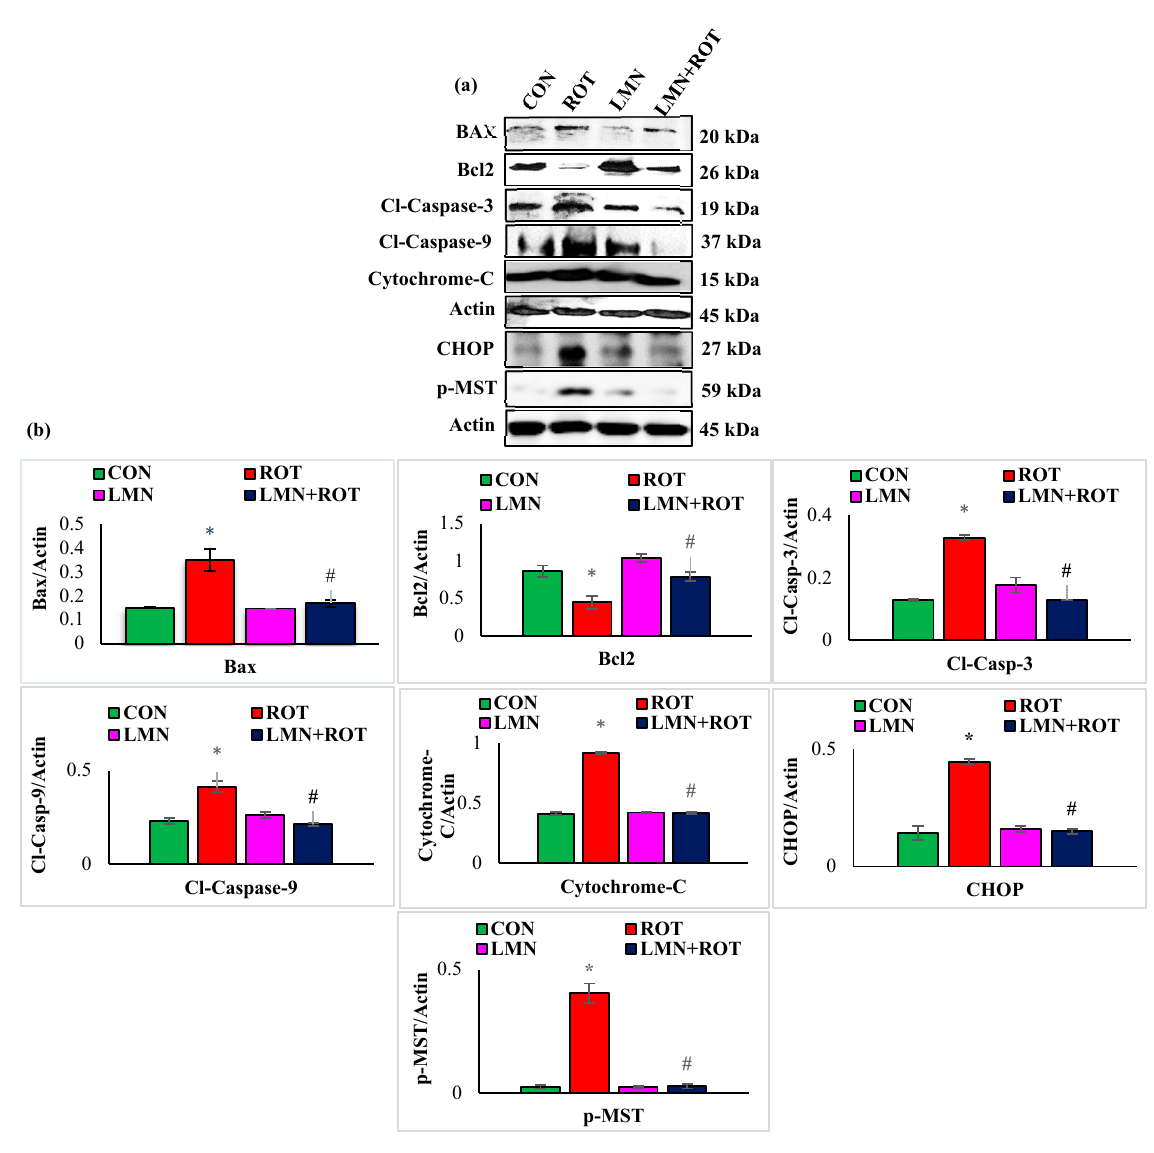
Figure 10. Immunoblotting and densitometric analysis of Bcl2. Antiapoptotic protein and pro-apoptotic proteins, including Bax, cytochrome-C, cleaved caspase-3, cleaved caspase-9, CHOP, p-MST were evaluated in the striatum ( a , b ). Immunoblotting was performed in duplicate and the data are presented as mean ± SEM. * p < 0.05 CON vs. ROT; # p < 0.05 ROT vs. LMN + ROT (one-way ANOVA followed by DMRT). CON: normal control, ROT: rotenone, LMN: limonene, LMN + ROT: limonene and rotenone treatment.